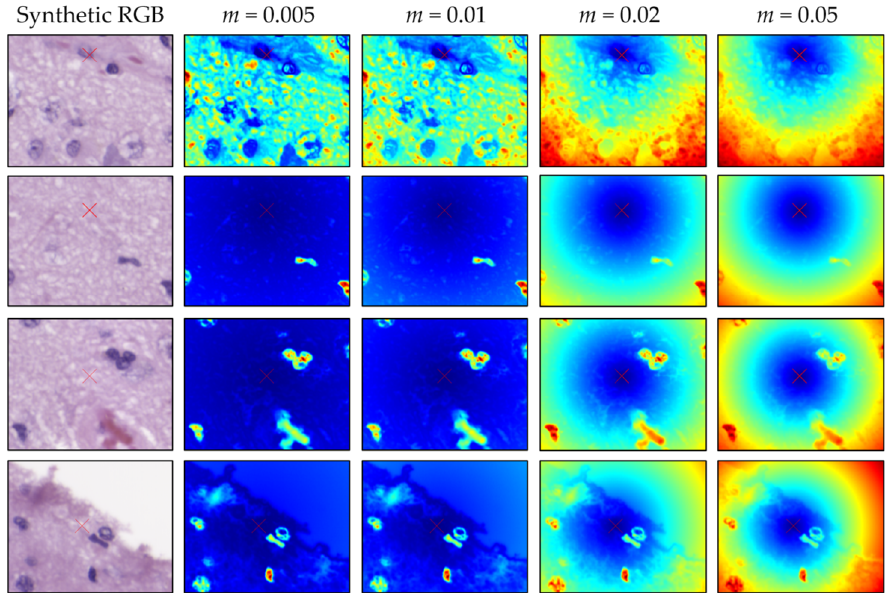
Figure 8. Different SLIC segmentation results depending on the distant hyperparameter ( m ). The rows present different image area example around a superpixel centroid (red cross). The first column shows the synthetic RGB image of the area and the remaining columns shows the distance between the superpixel centroid and the rest of pixels in the area with different values of m .